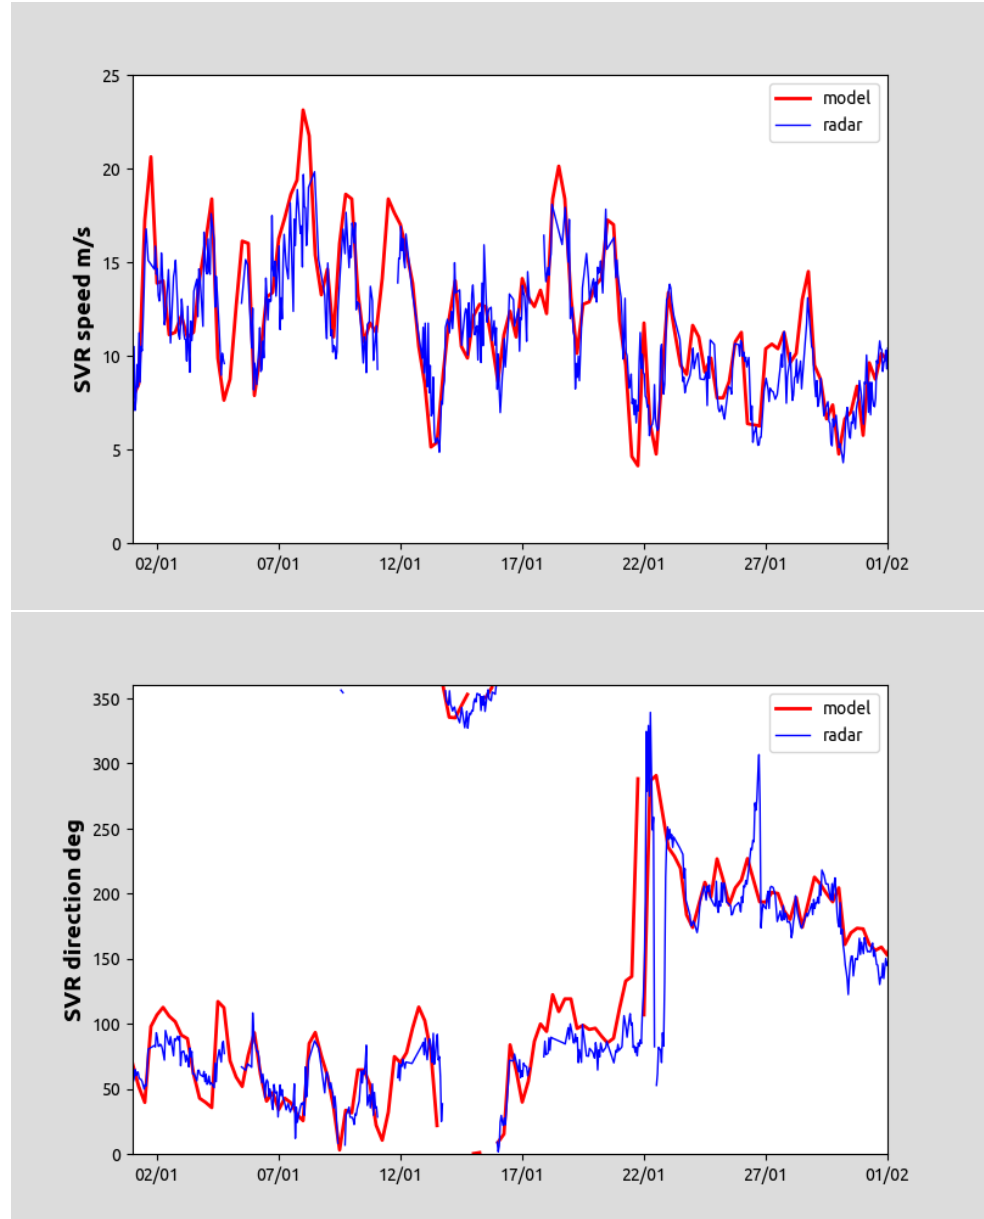
Figure 6. Comparison of radar and Met Office wind model wind speed ( upper ) and direction ( lower ) during January